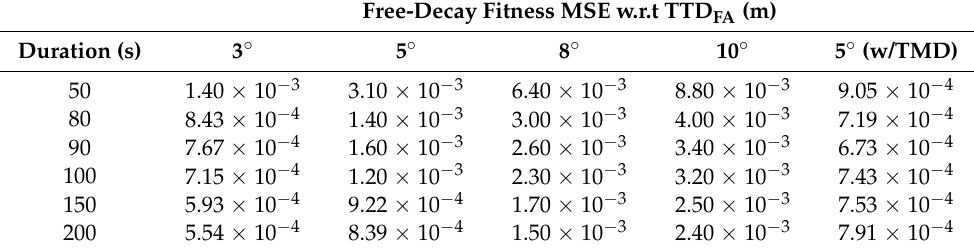
Table 4. Test duration selection